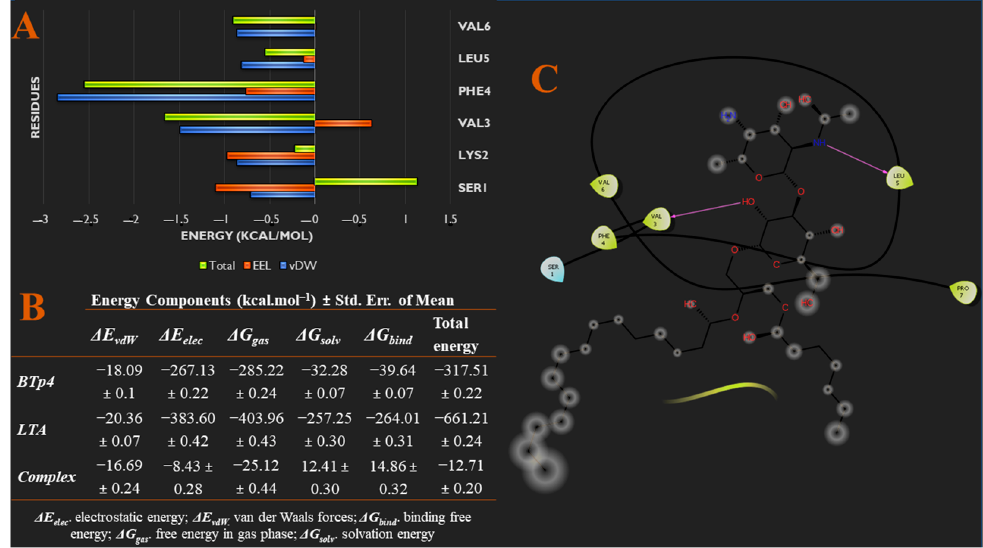
Figure 7. ( A ) Per-residue energy decomposition analysis showing specific energy contributions of each amino acid residue of BTp4 that contributes to binding. ( B ) Different energy contributions of each component of the system via MM/GBSA thermodynamics. ( C ) Binding interaction diagram of BTp4 to residues of